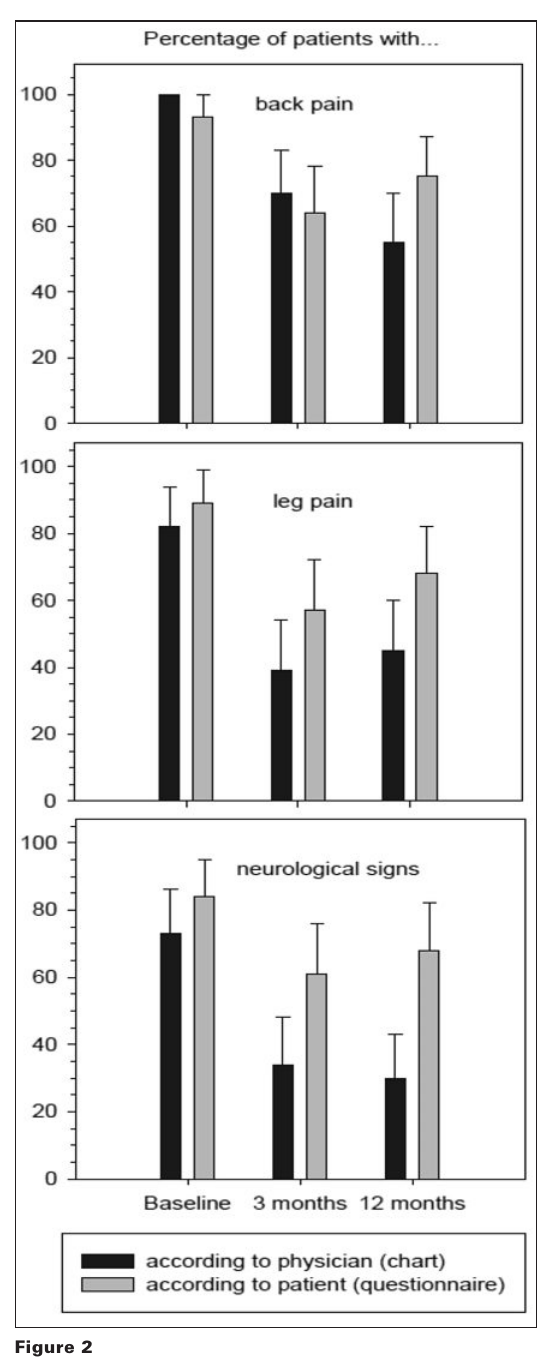
Agreement between doctor and patient by symptom (back/buttock pain, leg pain, neurological symptoms; error bars are Blyth-Still-Casella 95% confidence